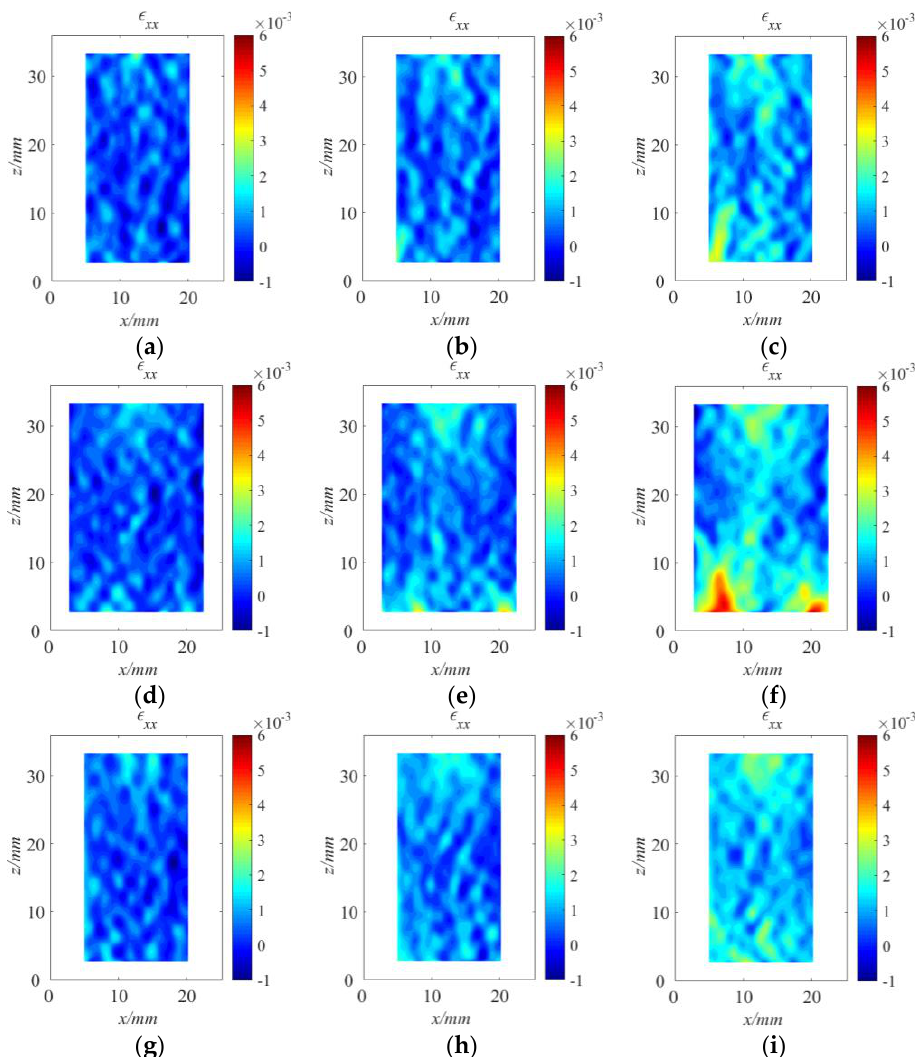
Figure 5. Contour plots of ε xx strain fields of the sectional images in step 4, step 5 and step 6. ( a – c ) along y = 6.20 mm, respectively; ( d – f ) along y = 12.50 mm, respectively; ( g – i ) along y = 18.80 mm, respectively.